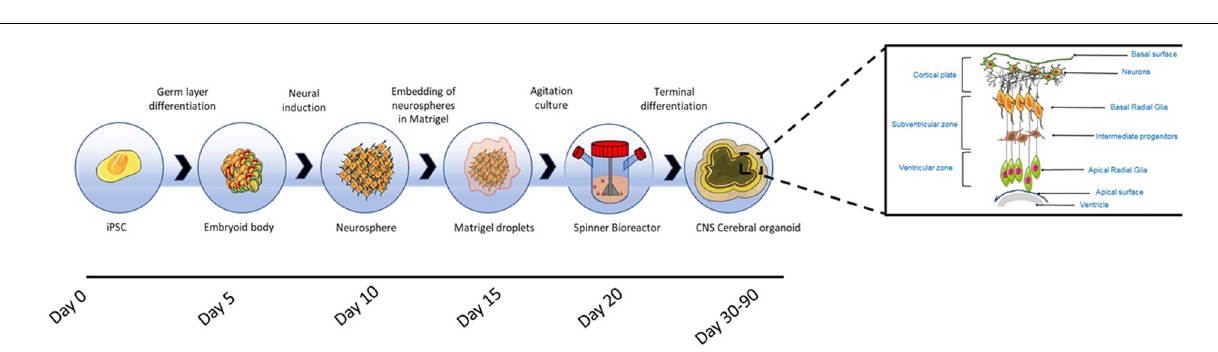
FIGURE 5 | Cerebral organoid formation. Cerebral organoids originate from pluripotent stem cell derived embryoid bodies cultured in low concentrations of bFGF-2 and with ROCK inhibitors to prevent anoikis. The embryoid bodies are differentiated toward neuroectoderm, resulting in the formation of neurospheres, which are embedded into Matrigel hydrogel droplets. After the embedding, budding neuroepithelia generate fluid filled cavities reminiscent of ventricles. The neuroepithelium begins to migrate outwardly to generate the cortical layers consisting of Cajal-Retzius cells, deep and superficial cortical progenitors. On exposure to retinoic acid, cerebral organoids self-organise through self-patterning mechanisms to display diverse populations of neural progenitors including radial glia, which expand forming cerebral structures (Lancaster and Knoblich, 2014). The region in which radial glia originate, recapitulates the in vivo VZ and SVZ (Kelava and Lancaster, 2016a). Prior to neurogenesis, radial glia are formed from the neuroepithelial cells and facilitate the migration of the neural and glial progenitors (Howard et al., 2008; Johns, 2014); these cells are characterised by the asymmetric self-renewal division leading to the generation of one neuron and one radial glia (Gotz and Huttner, 2005; Lancaster and Knoblich, 2012). Radial glia migrate, establishing the SVZ, where cells divide symmetrically forming intermediate progenitors (Haubensak et al., 2004; Miyata et al., 2004). Radial glia produce outer radial glia in the SVZ, which are self-renewing (Fietz et al., 2010; Hansen et al., 2010). Radial glia residing in the VZ divide at the apical surface adjacent to the ventricle. Intermediate progenitors and basal radial glia migrate basally to the SVZ. Neurons formed from radial glia, migrate radially from the ventricular and SVZ toward the basal region to establish the cortical plate (Johns, 2014; Kelava and Lancaster, 2016a). The neuronal migration depends on a layer of Cajal-Retzius cells and the outward migration is regulated by the protein reelin secreted by the latter cells (Frotscher, 1998). Within the intermediate zone of the cerebral hemispheres, neurons undergo apoptosis, and the region becomes the subcortical white matter (Johns,